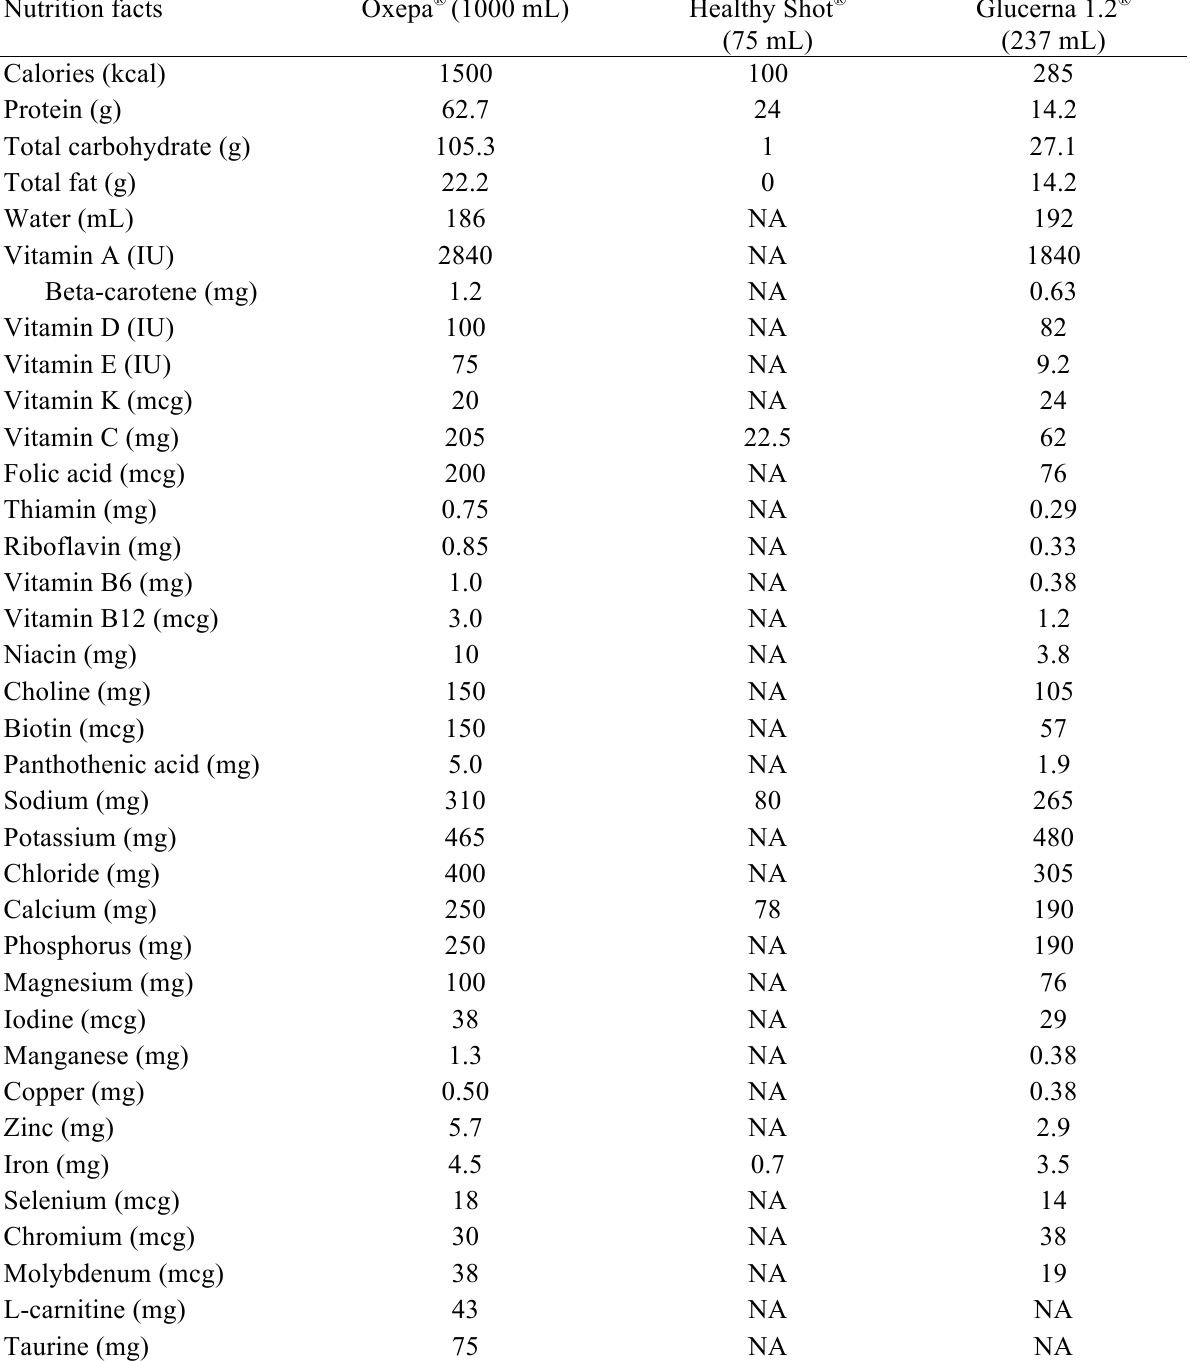
Table 2 Nutrition facts for nutrition intervention prescriptions Nutrition